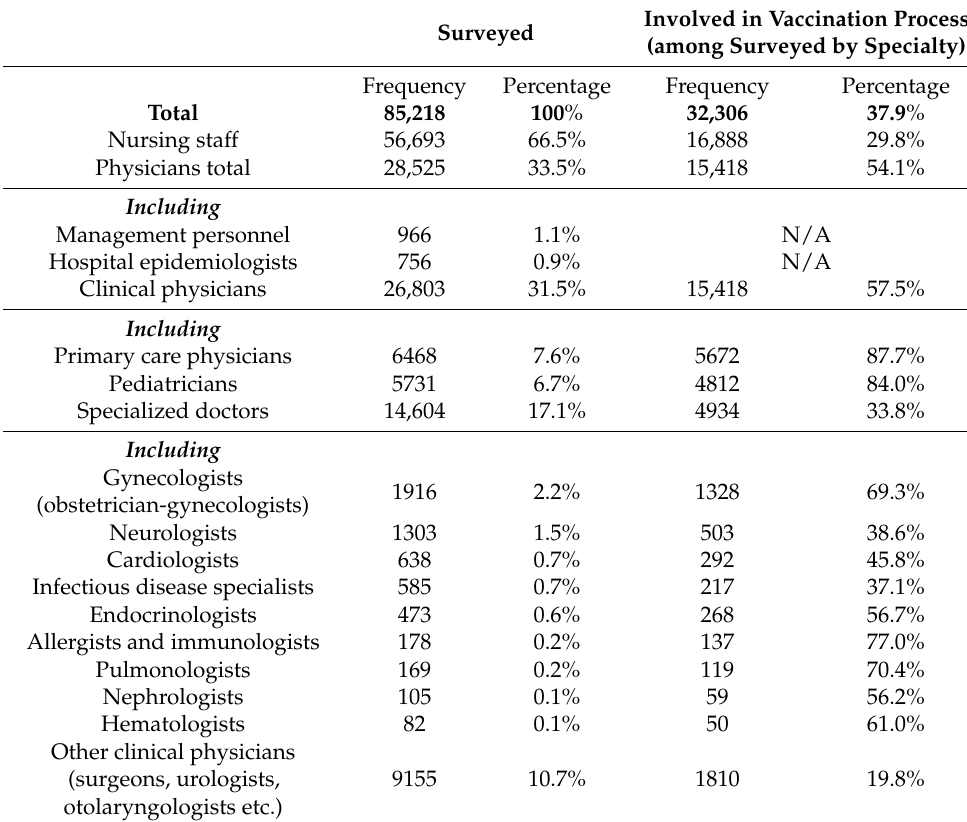
Table 2. Surveyed healthcare workers by specialty and their involvement in vaccination procedures. Involved in Vaccination Surveyed